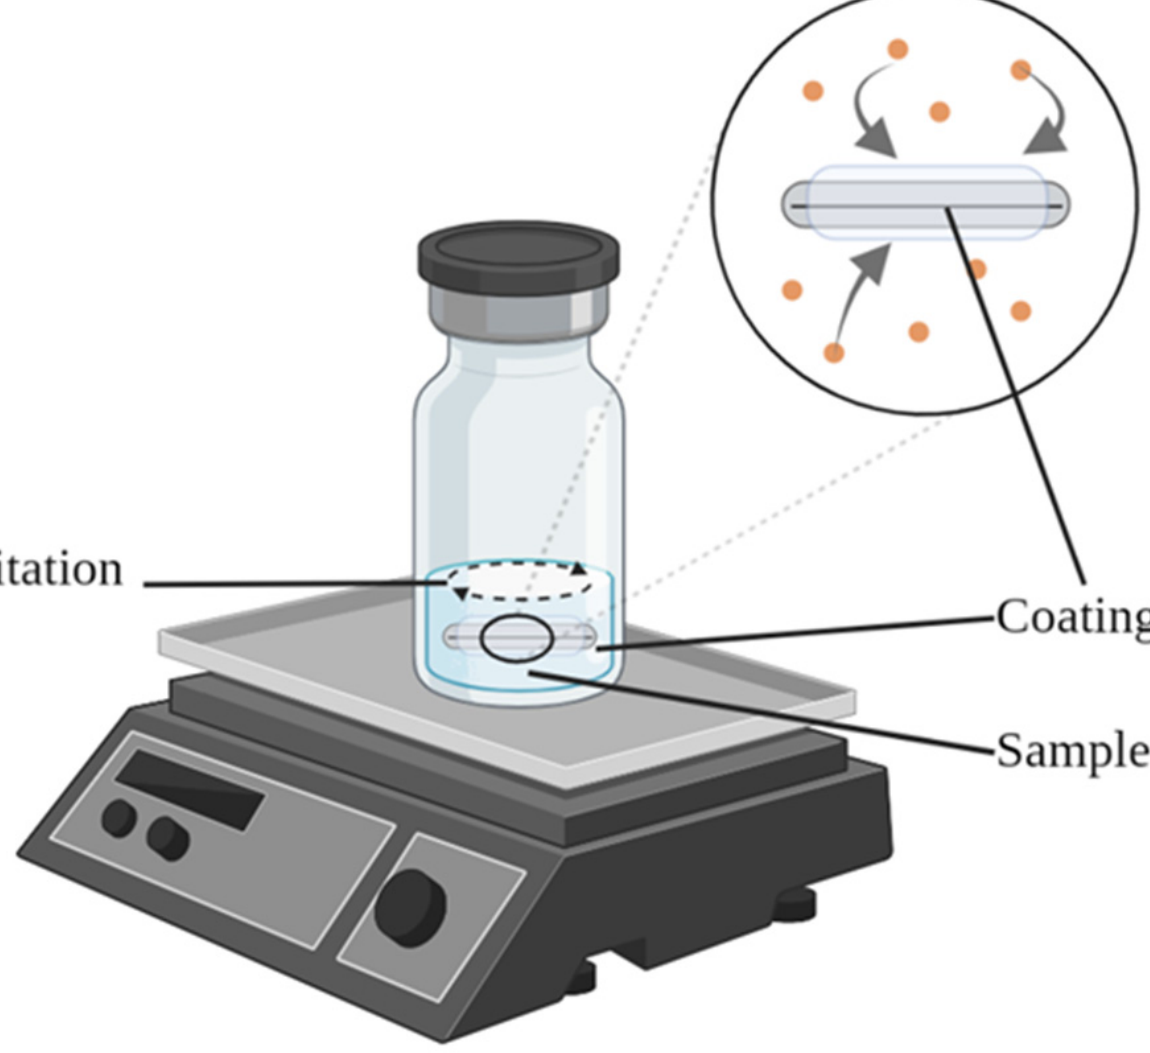
Figure 3. A system design demonstrating the SBSE.